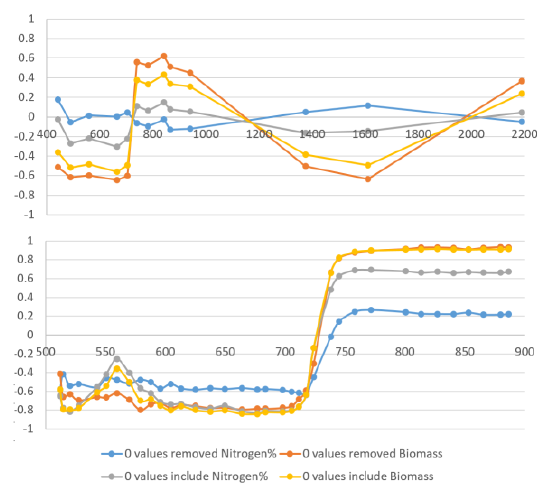
Figure 2. Pearson correlations (R) between reference measurements of biomass and nitrogen content between Sentinel 2 bands (top) and UAV FPI bands (bottom). The values near to zero indicate that linear regression is very poor and values near to +/-1 indicate strong correlation. X-axis is presenting wavelength (nm) of the spectral band. Secondly, two vegetation indices, NDVI (Normalized Difference Vegetation Index) and GRVI (Green-Red Vegetation Index) were selected to use as features. To select bands of hyperspectral and Sentinel-2 data to use for indices, every possible band combinations were correlated to ground reference and the best of them were used. For example, Reddersen et al. (2014) have used same approach earlier. In figure 3 the best combination of FPI bands was found using bands 27 (740 nm) and 32 (835 nm) to providing 0.948 correlation to reference biomass data.